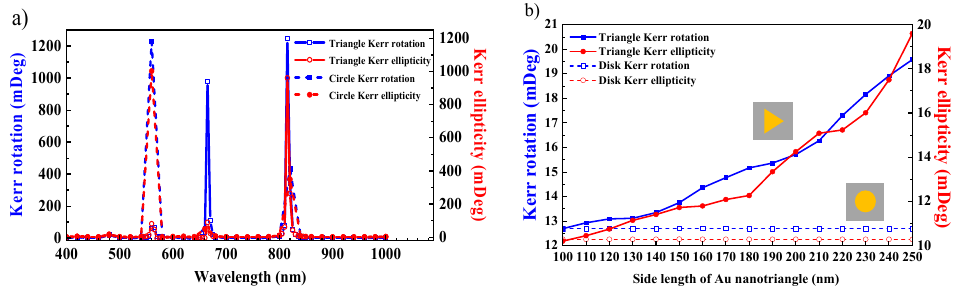
Figure A1. Variation in Kerr rotation and ellipticity with the incident wavelength ( a ) and side length of Au nanotriangle ( b ).